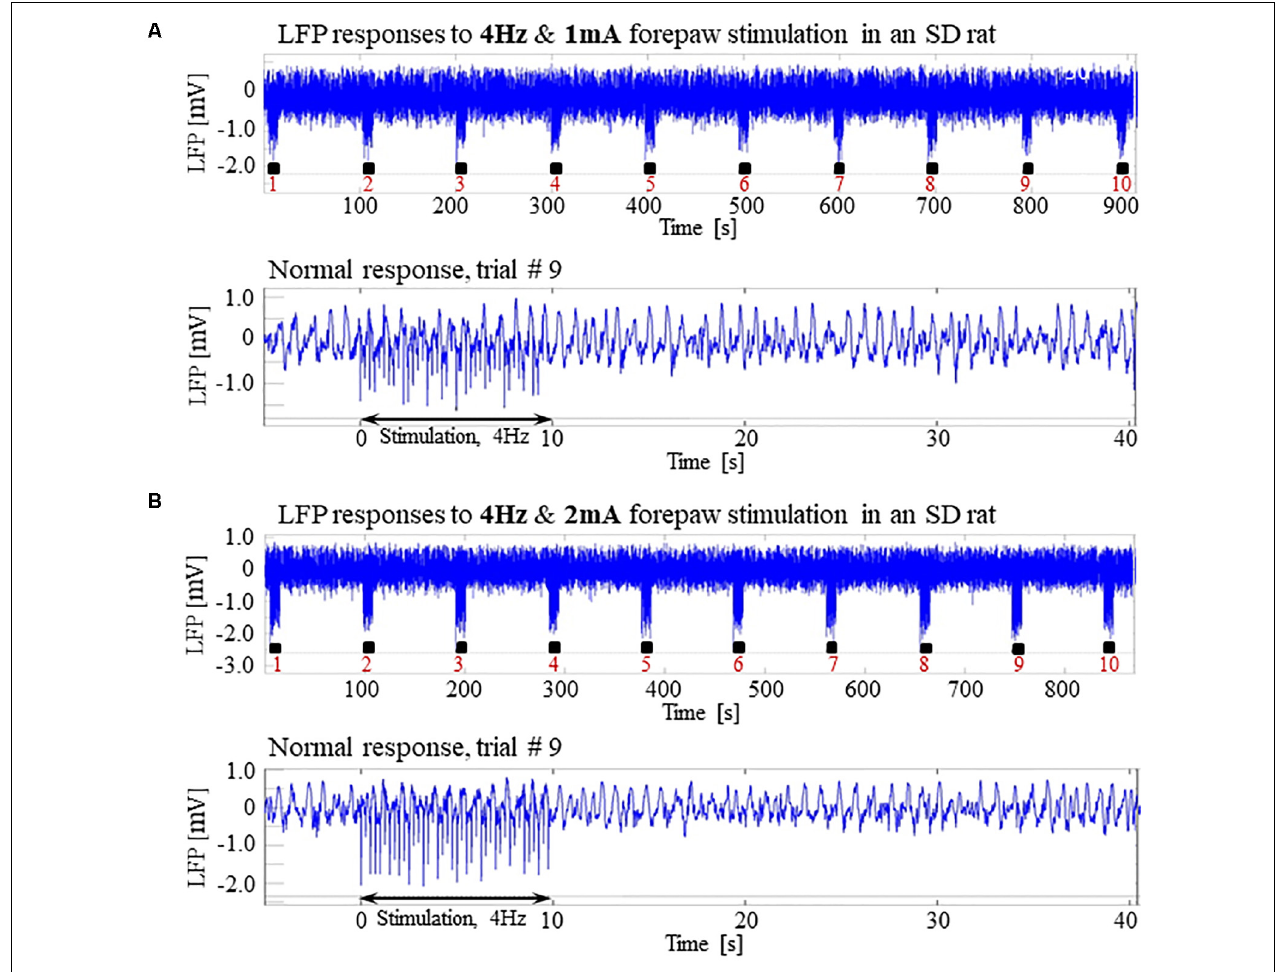
FIGURE 6 | Normal LFP responses to forepaw stimulation administered at 4 Hz in SD rats under dexmedetomidine and buprenorphine. The data presented in this figure were obtained from 3 rats under dexmedetomidine and buprenorphine sedation. (A) Top: Normal LFP responses obtained from area S1FL, in response to 4 Hz & 1 mA forepaw stimulation. The panel shows ten trials, each with 10 s-long stimulation. Bottom: A magnification of the normal evoked response from the ninth trial. (B) Top: Normal LFP responses to 4 Hz & 2 mA forepaw stimulation. Bottom: A magnification of the normal evoked response from the ninth